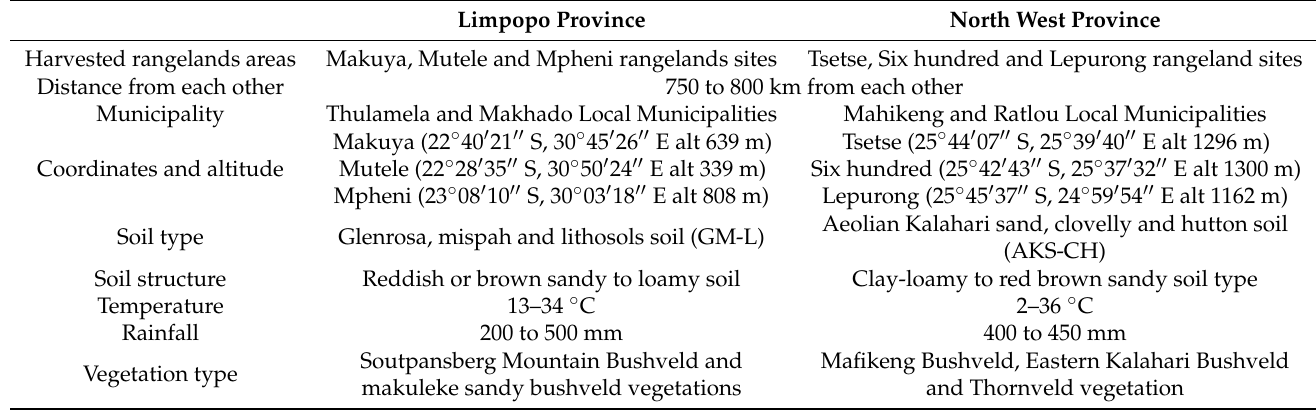
Table 8. Information on soil type, coordinates, altitude, distance and vegetation types of the sampling sites.